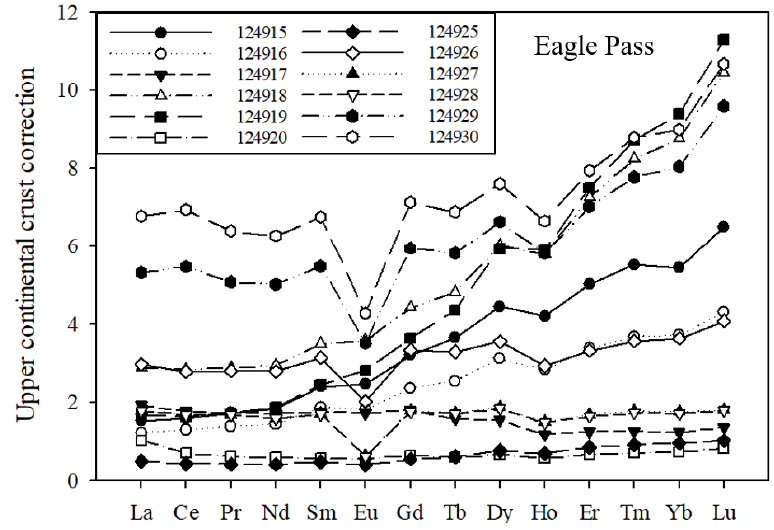
Figure 11. Upper Continental Crust normalized REE spider plots (after Taylor and McLennan [71]) for the Eagle Pass coal and clay lithologies.